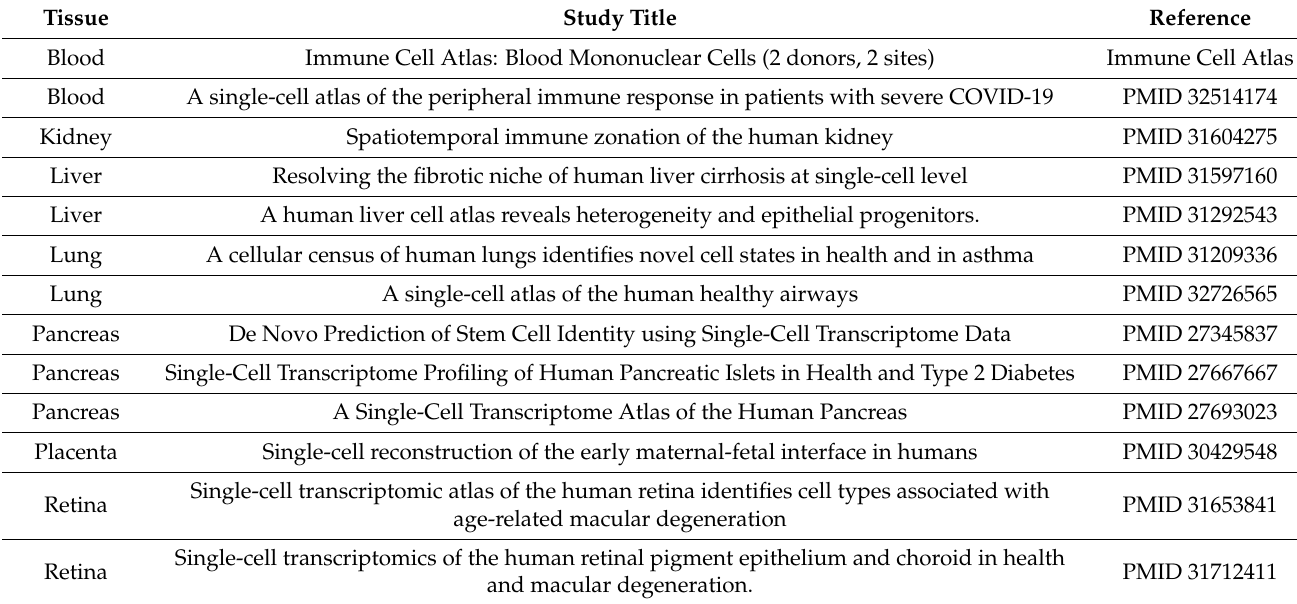
Table 1. List of studies that were used to tune the cluster annotation algorithm. The columns indicate (1) the tissue from which cells were derived in the study, (2) the title of the published study or dataset, and (3) the reference for the study [26–30,33,35–41]. The three pancreas datasets were integrated for one single analysis of cluster annotation.